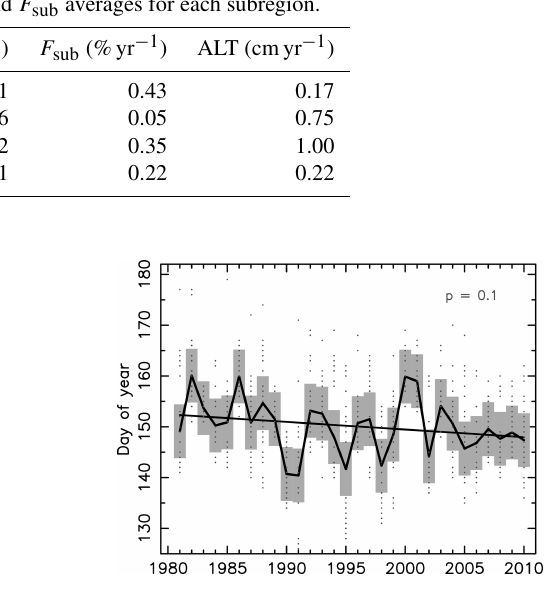
Figure 12. Date of maximum daily Q 1981–2010 for all 42 North Slope rivers. Gray bar shows the 1 σ range around the average date (solid line). Dots indicate the date for each river. Linear least squares trend shown. Significance of linear trend (GLM) is approx- imately p = 0 .